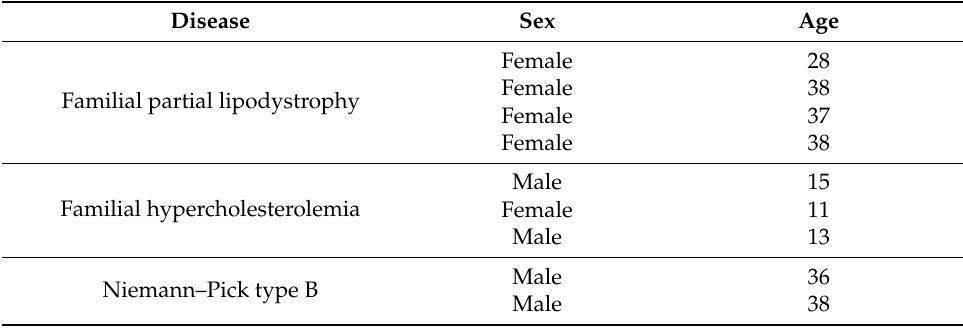
Table 1. Characteristics of study